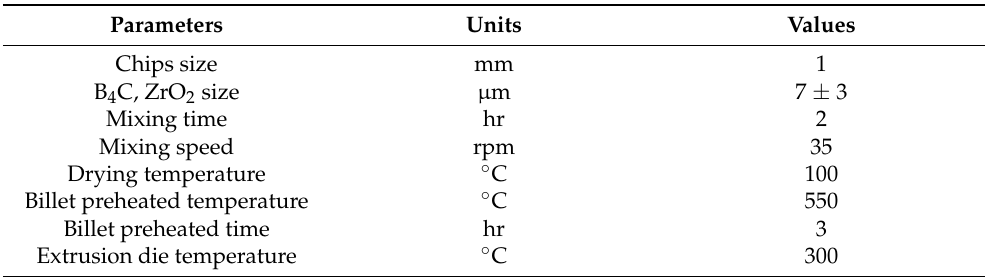
Table 1. Process parameters for preparing the Al6061-B 4 C/ZrO 2 composites and the subsequent hot extrusion process.